Question: Does the figure show an increasing or a decreasing trend?
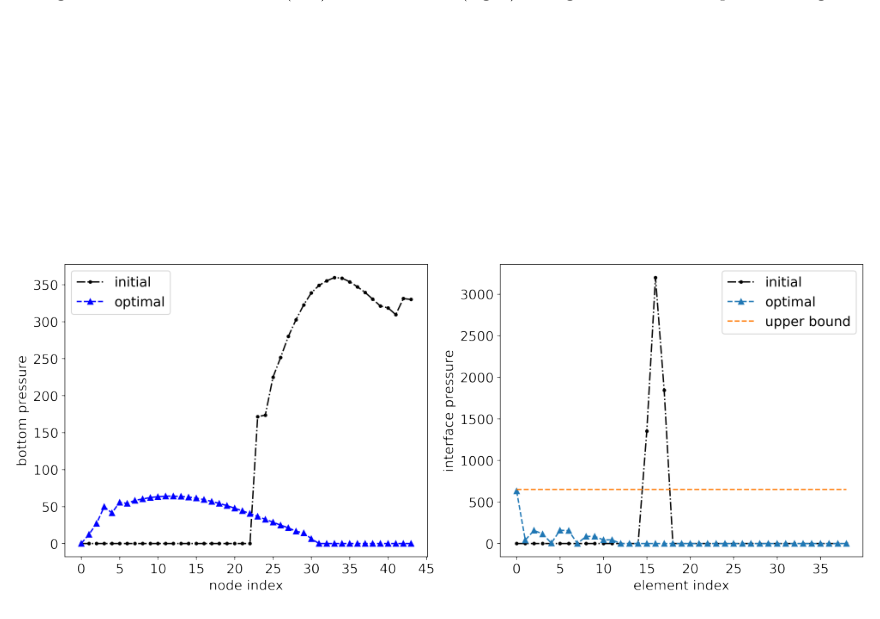
Answer: increasing